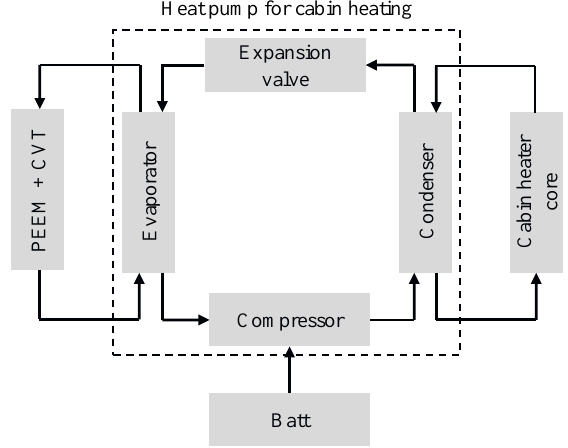
Figure A3. Schematic of an electric path waste heat recovery system.